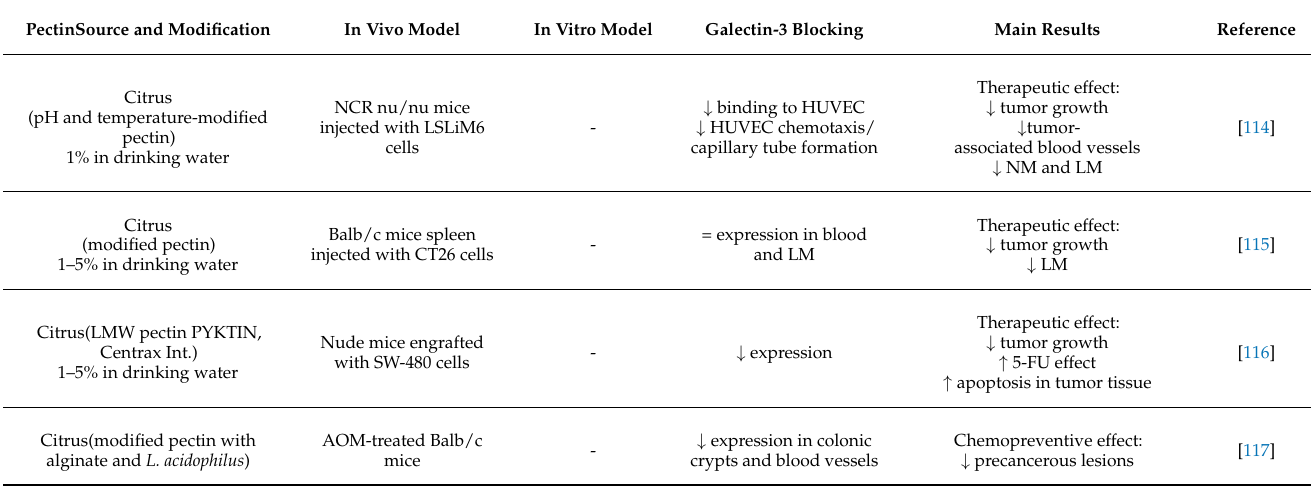
Table 2. Studies describing galectin-3-mediated effects of non-digestible carbohydrates in colorectal